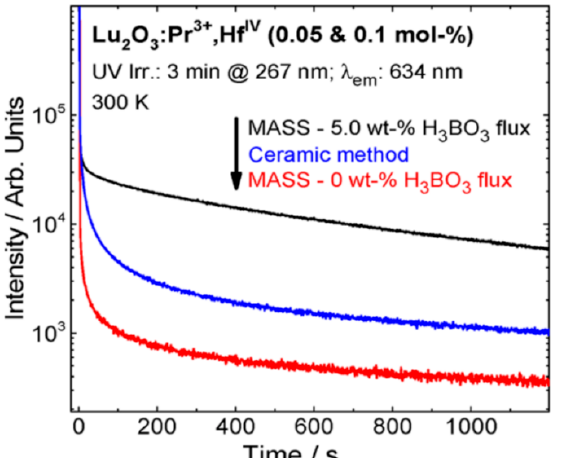
Figure 10. Persistent luminescence decay curves of Lu 2 O 3 :Pr 3+ , Hf 4+ materials obtained by conven- tional (blue curve), and microwave-assisted (black curve) solid-state methods, and the PeL decay of the MASS obtained materials without H 3 BO 3 flux (red curve) [62]. Copyright © 2016, American Chemical Society.